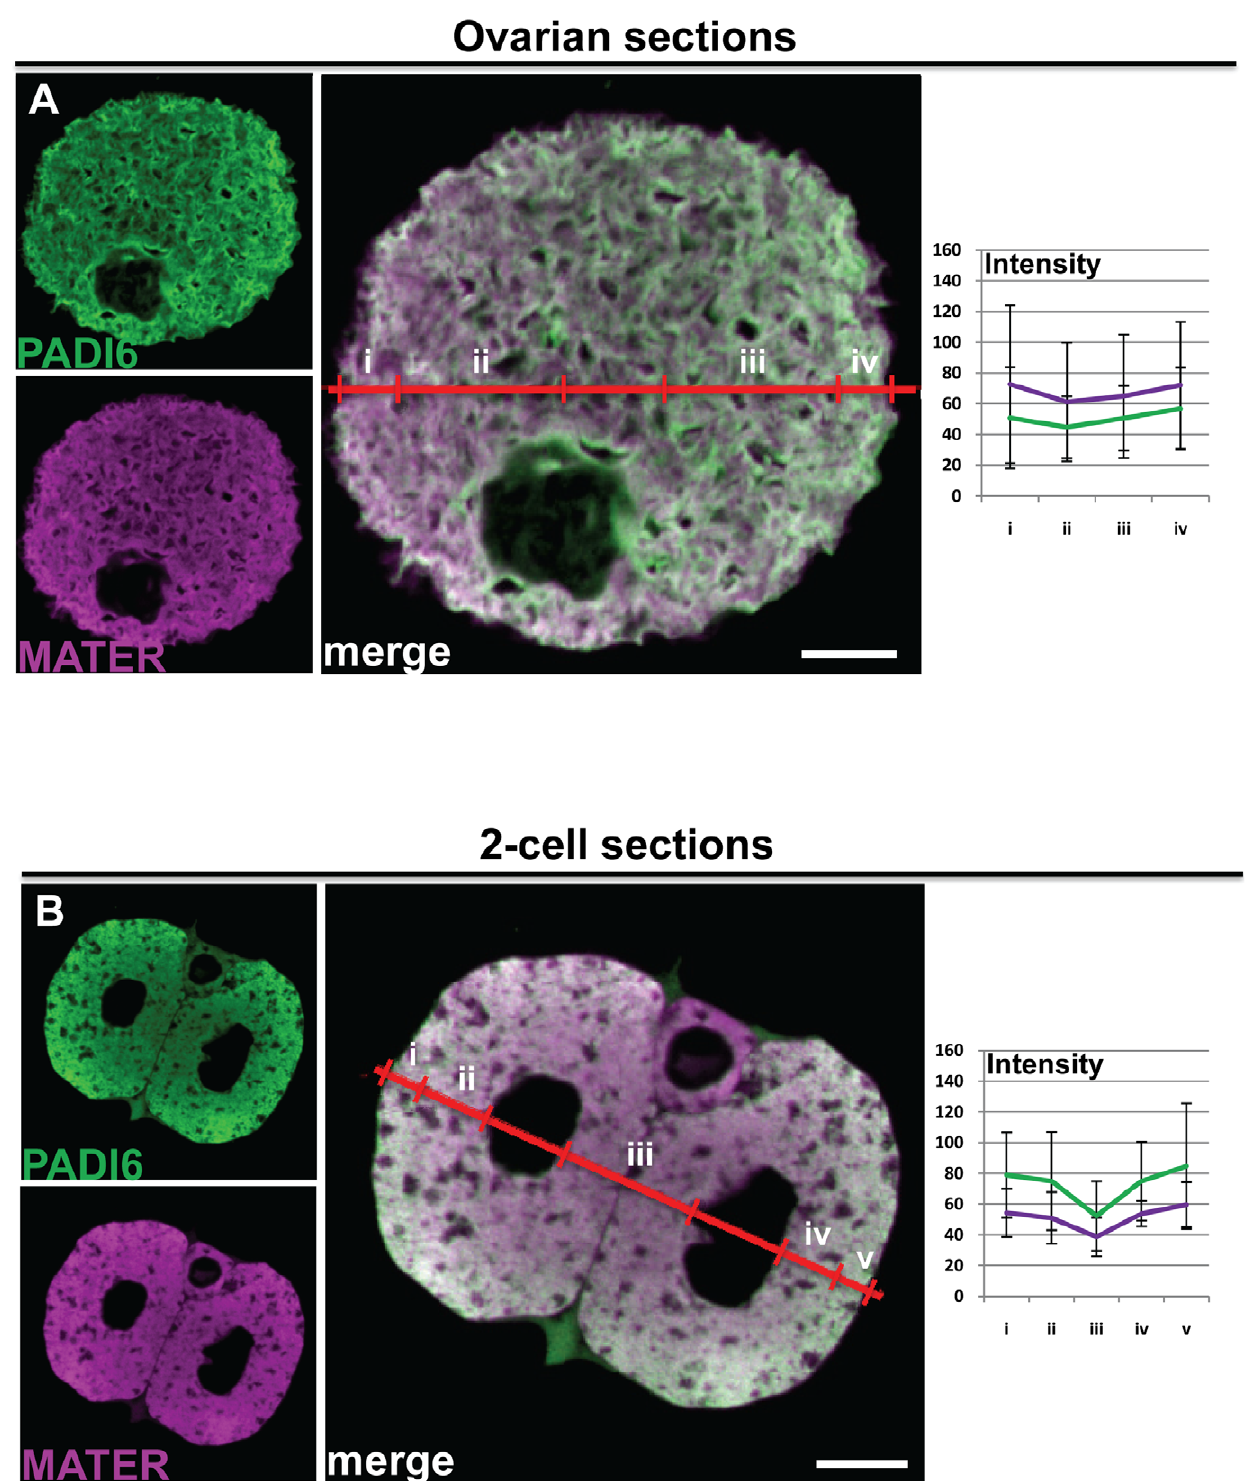
Figure 4. IF of cross sections reveal that PADI6 and MATER are primarily localized to the cytoplasm. Ovaries and oviducts were fixed, embedded in paraffin and sectioned before staining for IF. GV oocytes (A) and two-cell embryos (B) in the sections were visualized. PADI6 is shown in green and MATER in magenta. Included are graphs of the averages and standard deviations of four intensity profiles of four images per condition of the different stains in either cortical (i and iv) or cytosolic (ii and iii) zones for the oocytes or cortical (i and v), basolateral cytosolic (iii) or apical cytosolic (ii and iv) zones for the embryos. Bars, 10 m m.